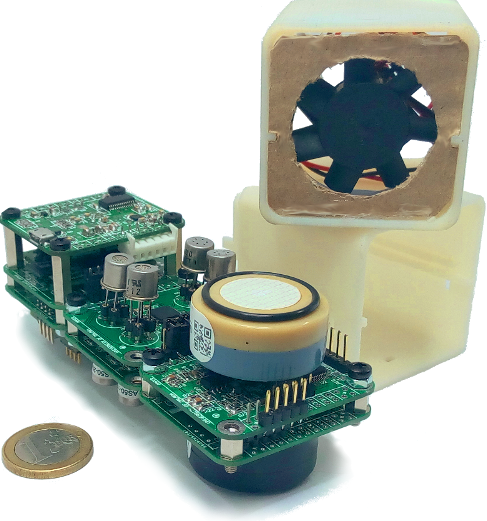
Figure 1. Picture of the e-nose prototype built for the IRO project. Its modular and compact design allows it to be easily mounted on a mobile robot and adapted to the application